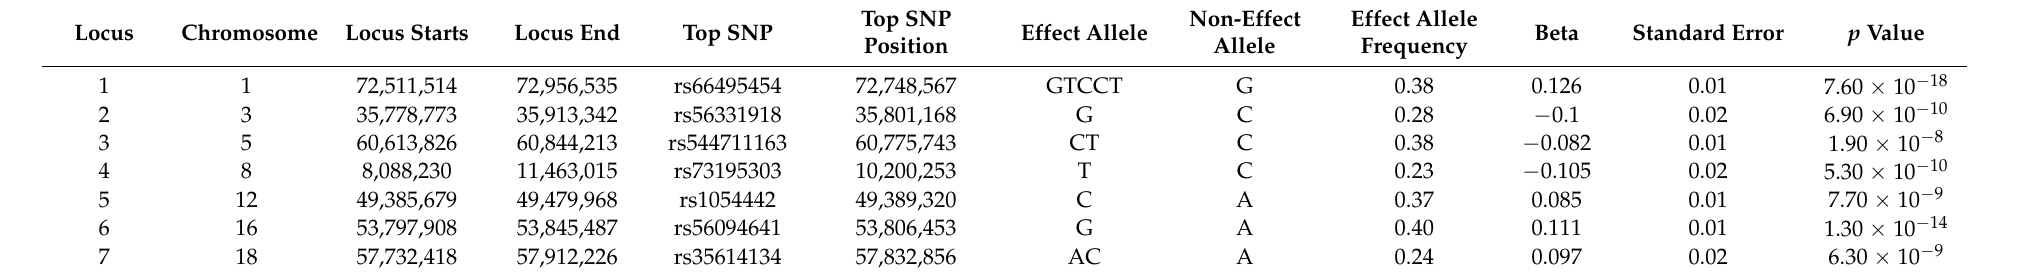
SNPs, single-nucleotide